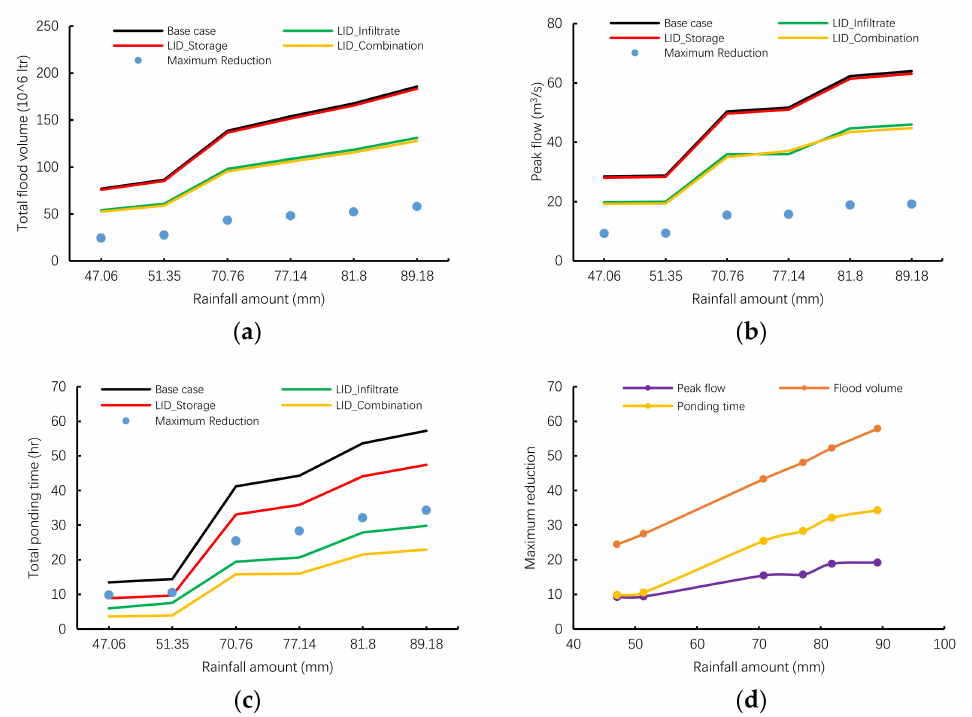
Figure 8. Relationship between hydrological characteristics and rainfall amounts: ( a ) Relationship between flood volume and rainfall amounts; ( b ) Relationship between peak flow and rainfall amounts; ( c ) Relationship between total ponding time and rainfall amounts; ( d ) Relationship between maximum reduction and rain amounts of various hydrological